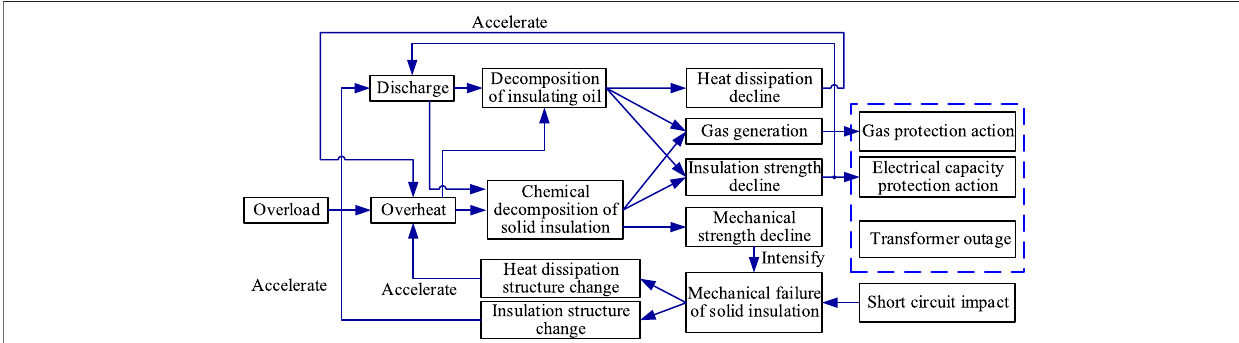
FIGURE 4 | Developing mechanism of a transformer ’ s internal latent